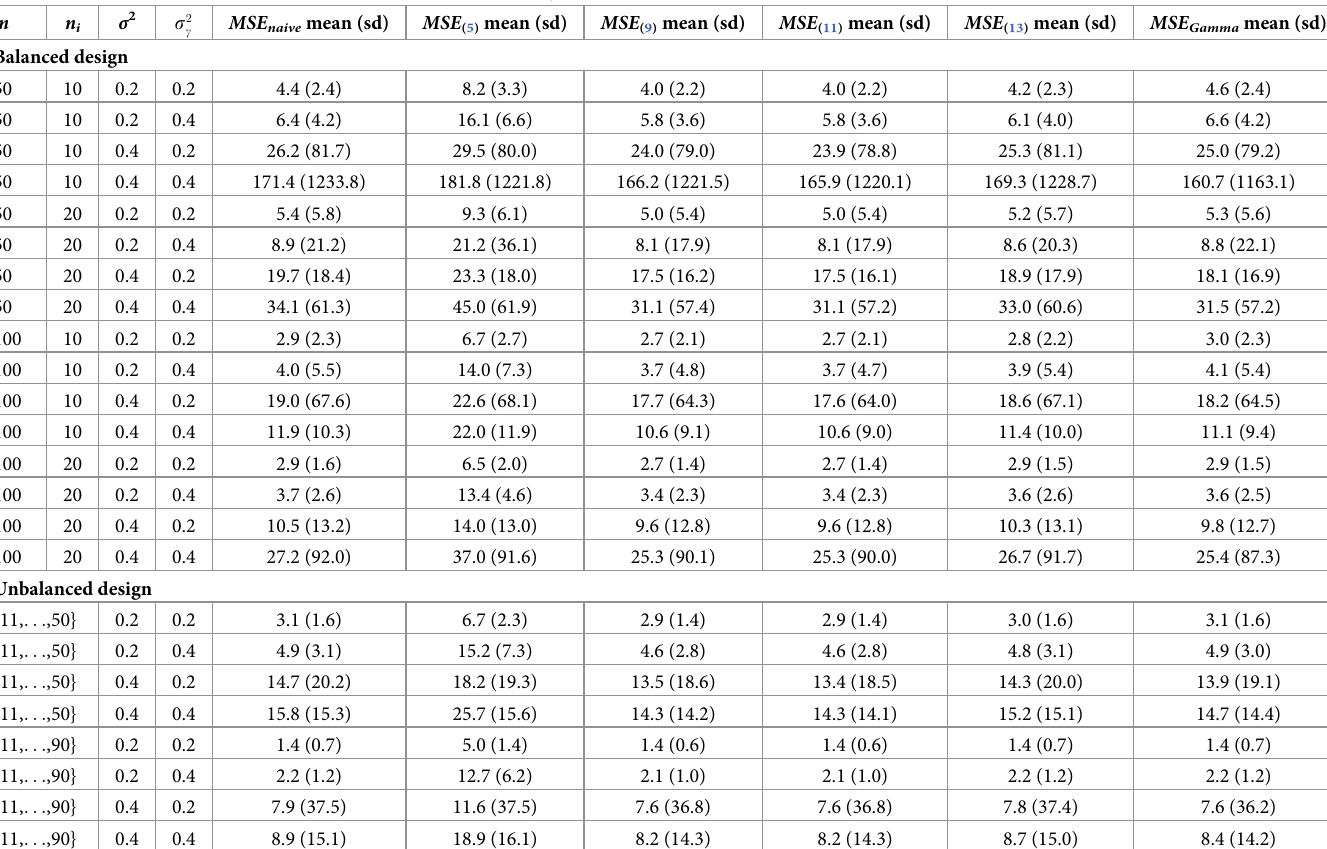
; for data simulated from a RIM in a logarithmic g